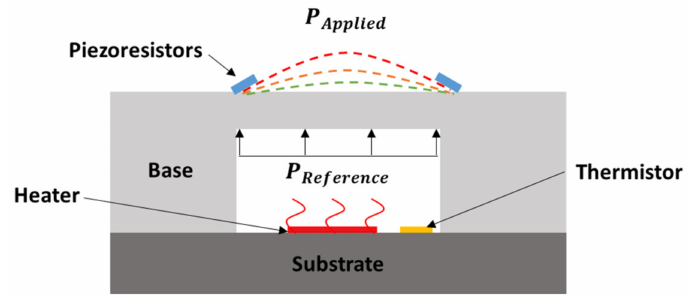
Figure 3. Simplified demonstration of the self-calibrating pressure sensor procedure where varying heater power is used to change the sealed reference cavity pressure, resulting in different sensor responses and calibration points (green, orange, and red dashed